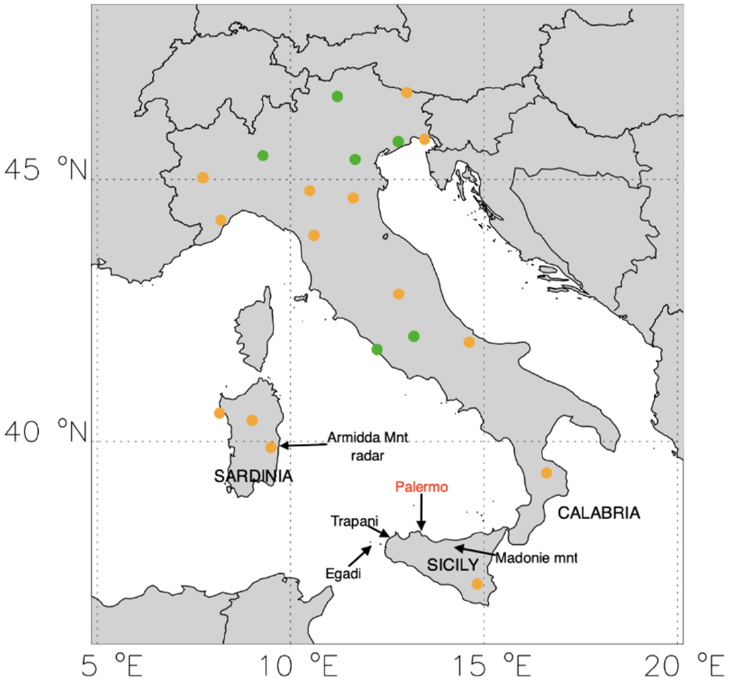
Figure 1. Position of the radars used for assimilation. Green dots are single polarization radars, orange dots are dual polarization radars. Names of locations cited in the text are also shown.